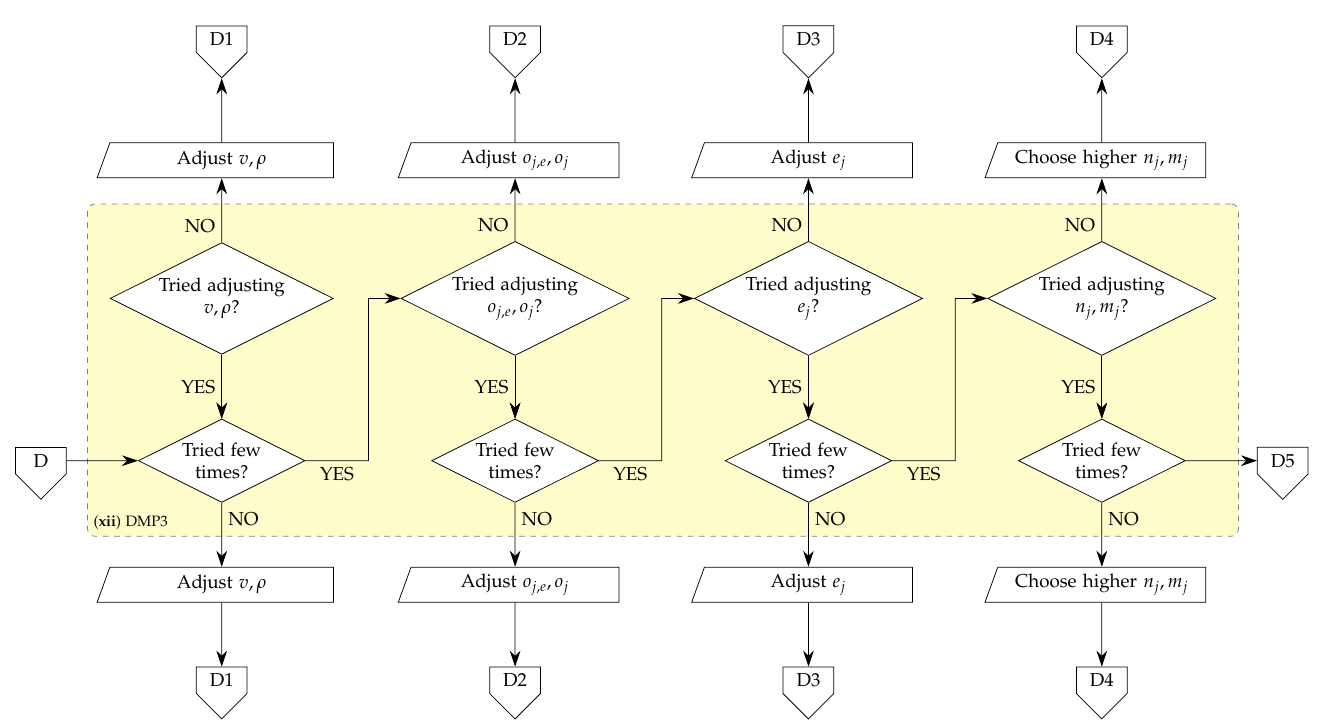
Figure 7. Decision making process 3 (DMP3)—The suggested order of adjustments that have to be made to the IQC analysis parameters and to the uncertain interconnected system to satisfy a given robustness criteria. First decision (D1) reflects the changes are being made to the IQC parameters (i.e., v and ρ ). Other decisions reflect the changes are being made to the uncertain interconnected system. Changes are being made to the orders of uncertainty weights first (D2), then to the orders of reduced order IOTFs (D3) and after that to the level of discretizations of subsystems (i.e., n j ) and/or to the orders of the model order reduced subsystems (i.e., m j )—collectively the fourth decision